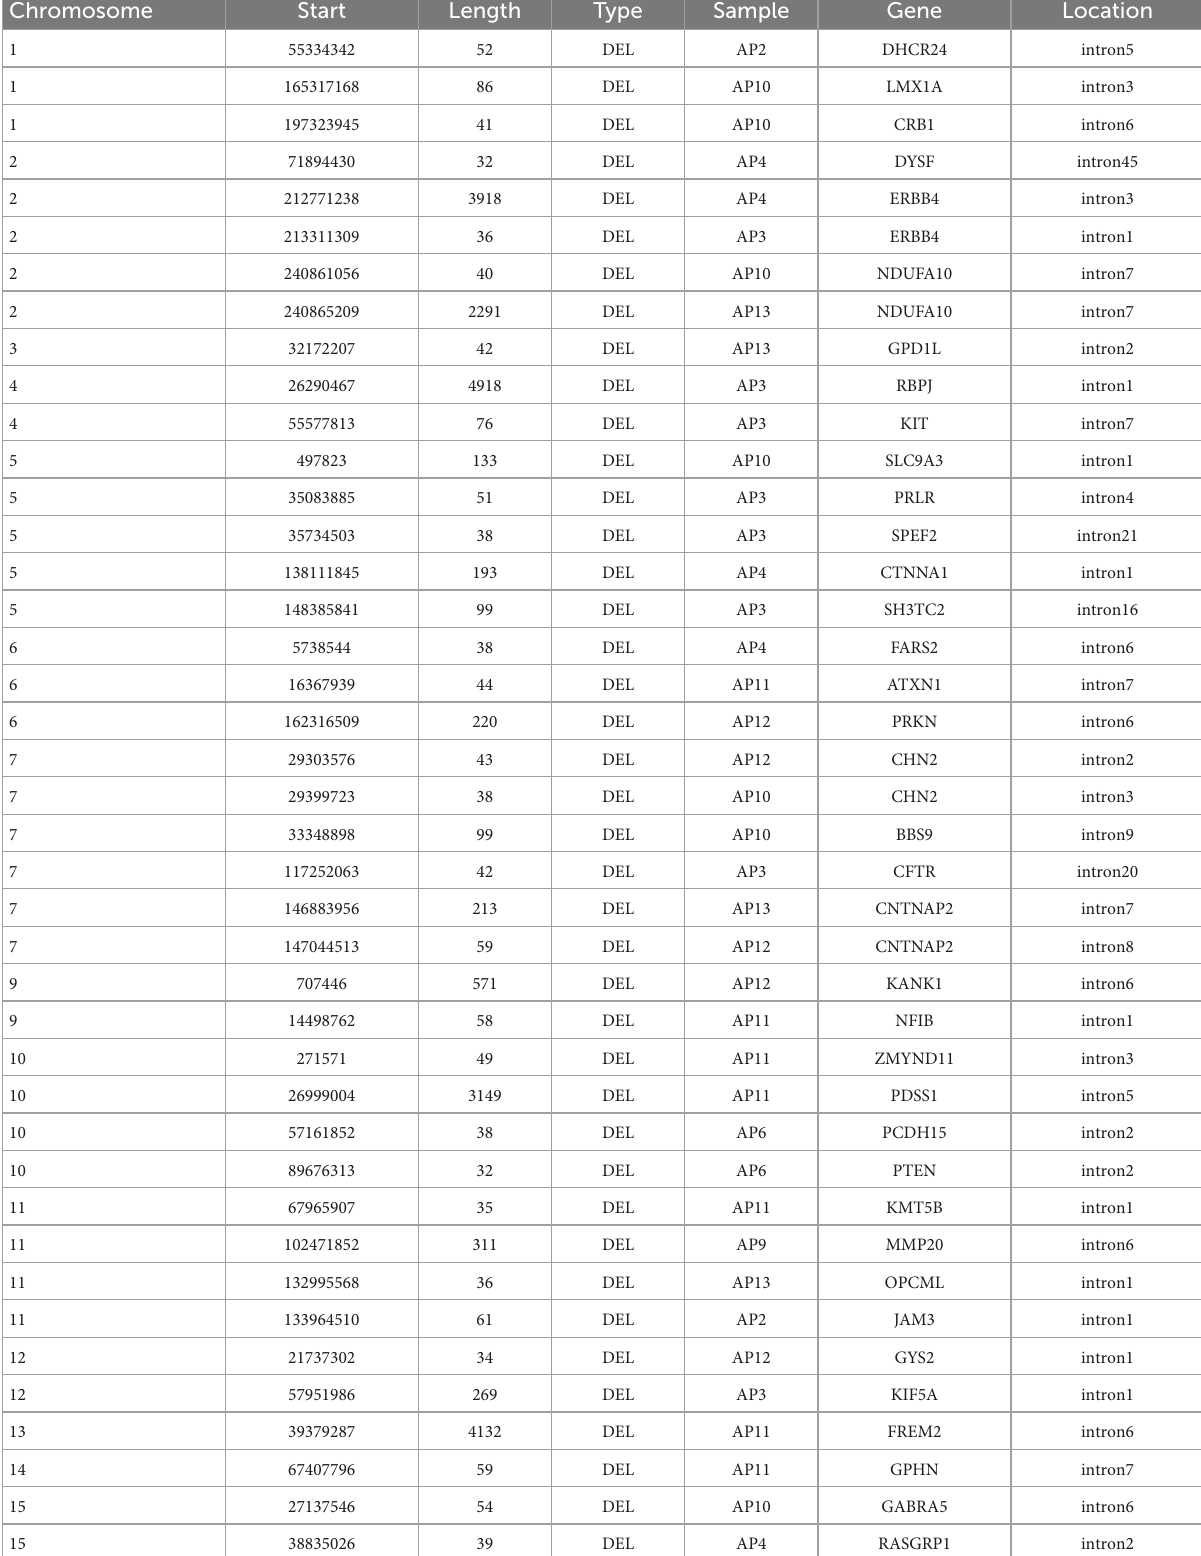
TABLE 1A 51 SVs/47 genes identified from PacBio, confirmed with Illumina, and found in 10 probands but not in 5 unaffected relatives. Chromosome Start Length Type Sample Gene